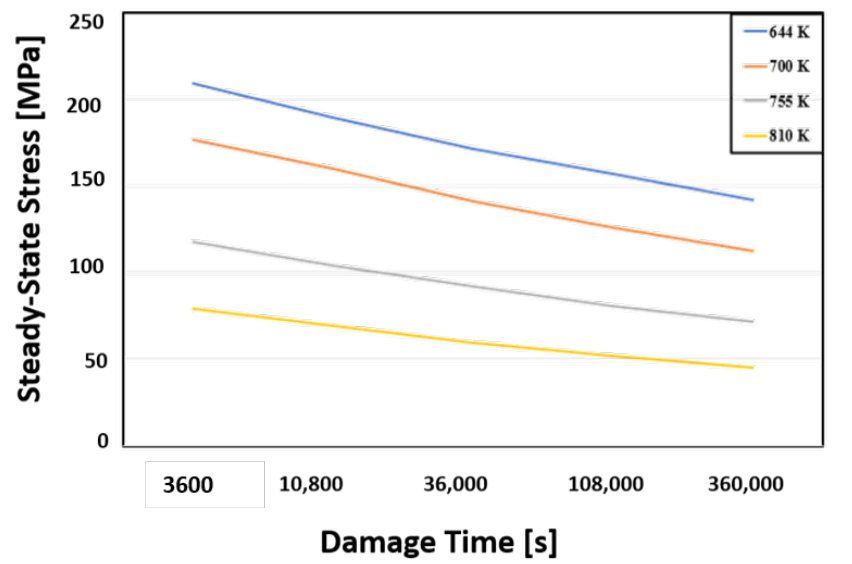
Figure 10. Steady stress vs. damage time